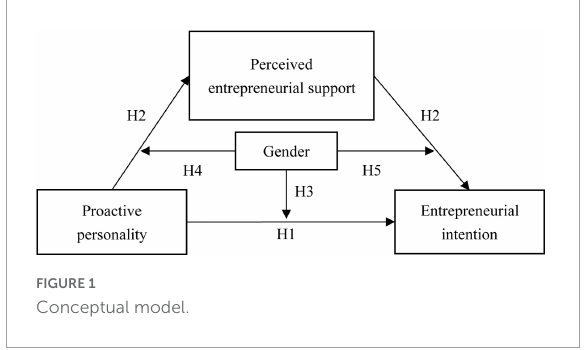
FIGURE1 Conceptual